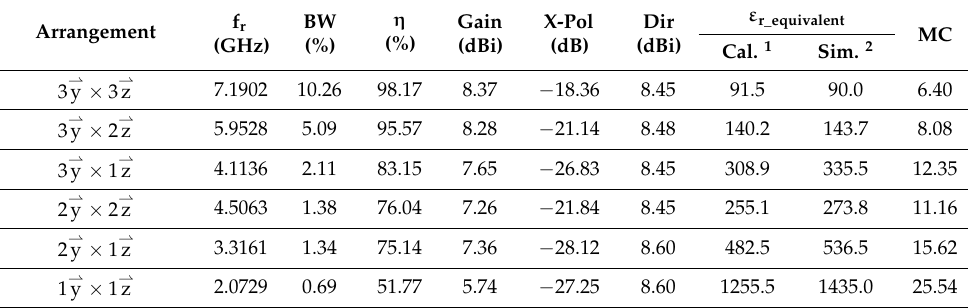
Table 3. Antenna performance of SRR arrays with different ring arrangements.